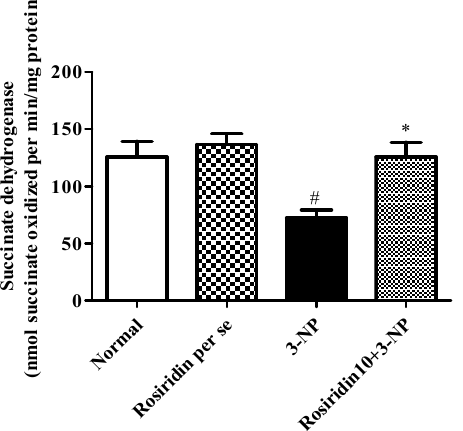
Figure 8. Effect of rosiridin on succinate dehydrogenase (SDH) activity. Values are expressed as the mean ± SEM (n = 6). Values are statistically significant at p < 0.05 (one-way ANOVA followed by Dunnett’s test). Express the data ( # p < 0.05) saline vs. negative control group; (* p < 0.05) negative control group vs. treatment group.